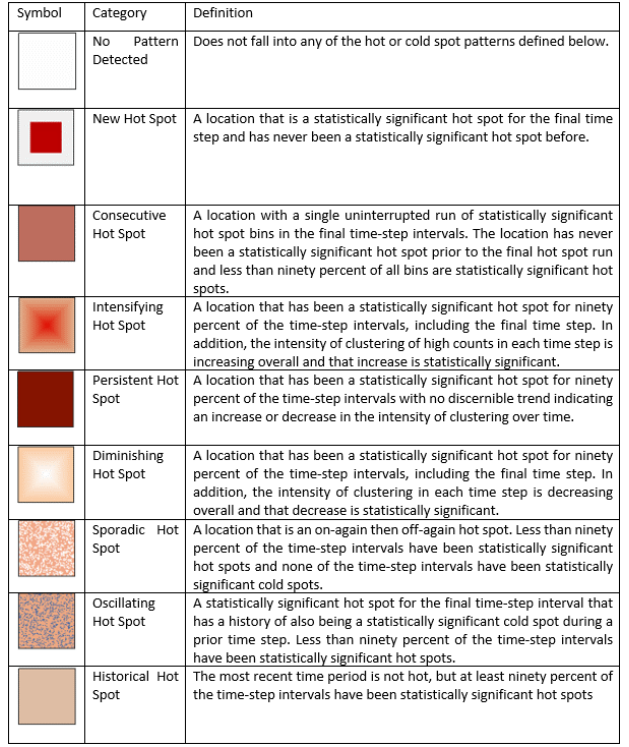
Figure A7. Hotspot